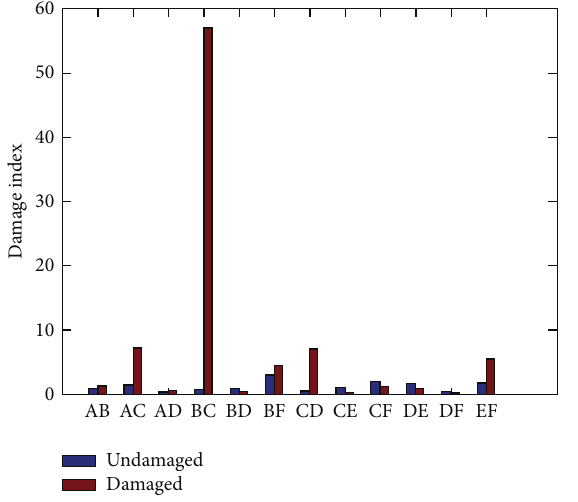
Figure 4: Damage index values for undamaged and damaged blade.